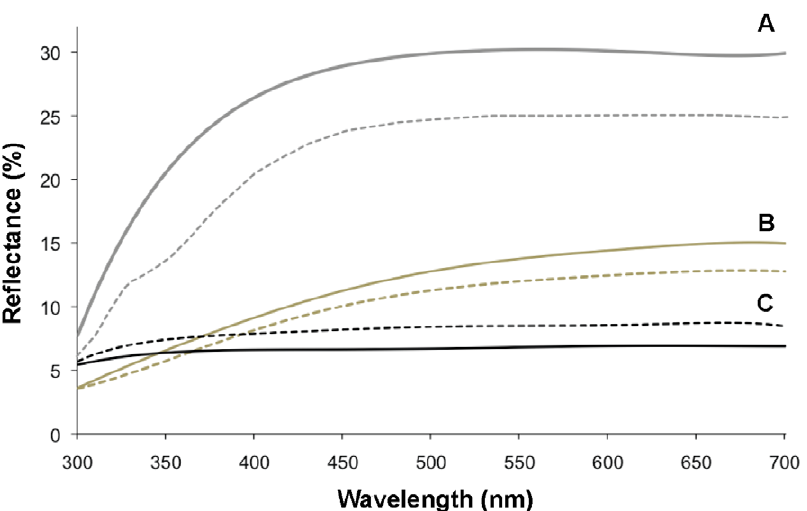
Figure 5. Spectral curves of feathers of affected and unaffected black-capped chickadees. Mean plumage reflectance curves for white A), grey B), and black C) body regions of birds unaffected (solid lines; n =10) and affected (dashed lines; n =10) by avian keratin disorder.